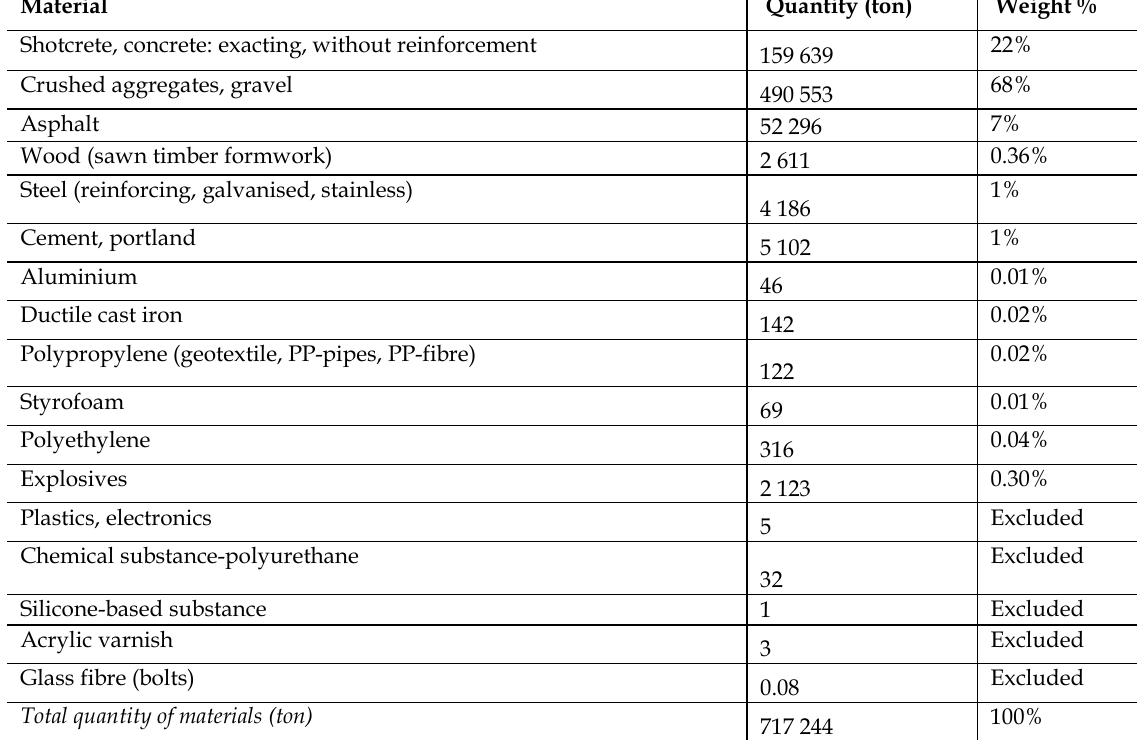
Table 2. Material quantities for the main rock tunnels in Norra Länken (7.5